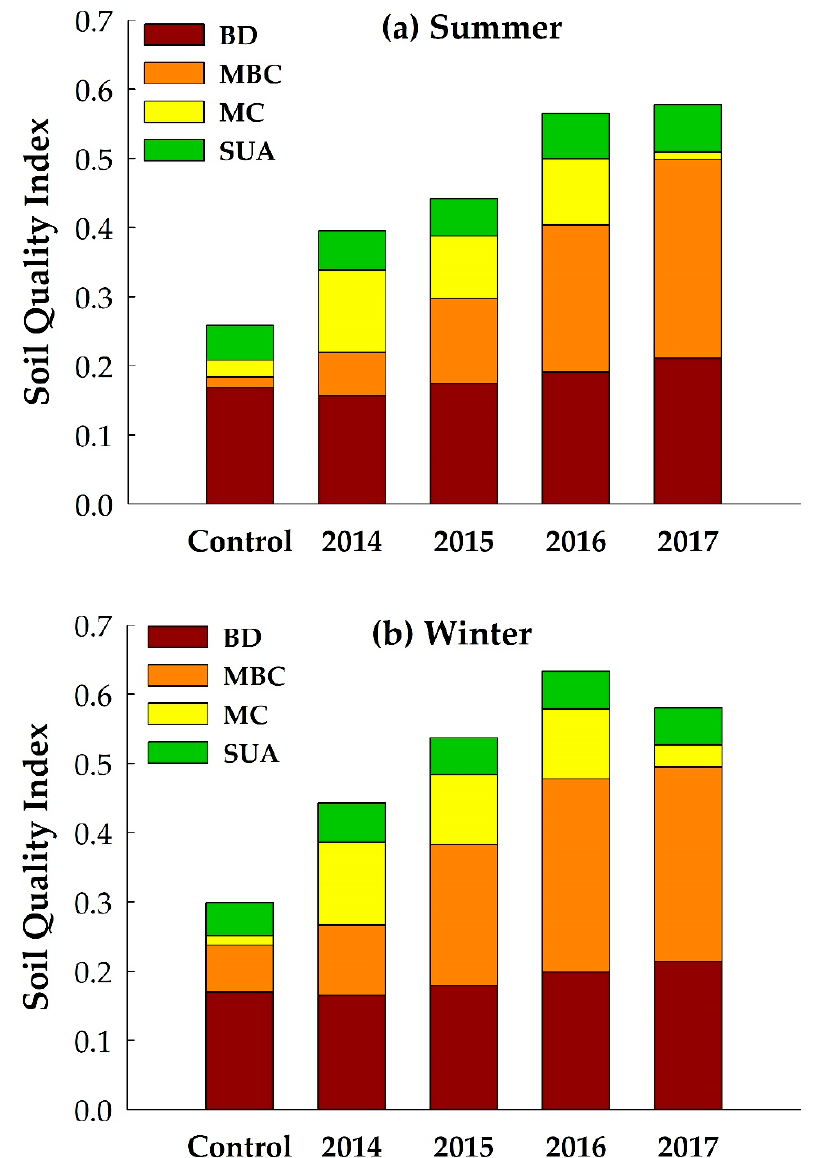
Figure 5. Effect of D. sissoo plantation on the soil quality index (SQI) of the study site (Barkachha, Mirzapur, Eastern UP, India) during the four-year period (2014–2017), in comparison to the SQI of a control site at the same locality (without plantation) during the year 2014 as a reference/initial value. ( a ) SQI for summer season, and ( b ) SQI for winter season.